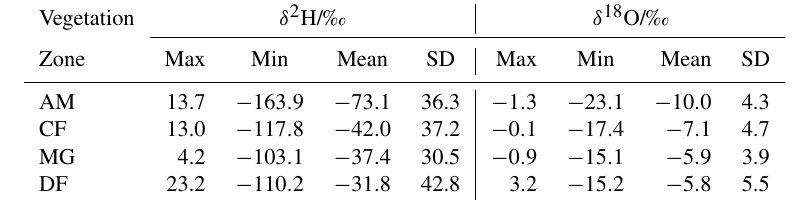
Table 2. General characteristics of precipitation δ 2 H and δ 18 O in different vegetation areas from April to October 2017.